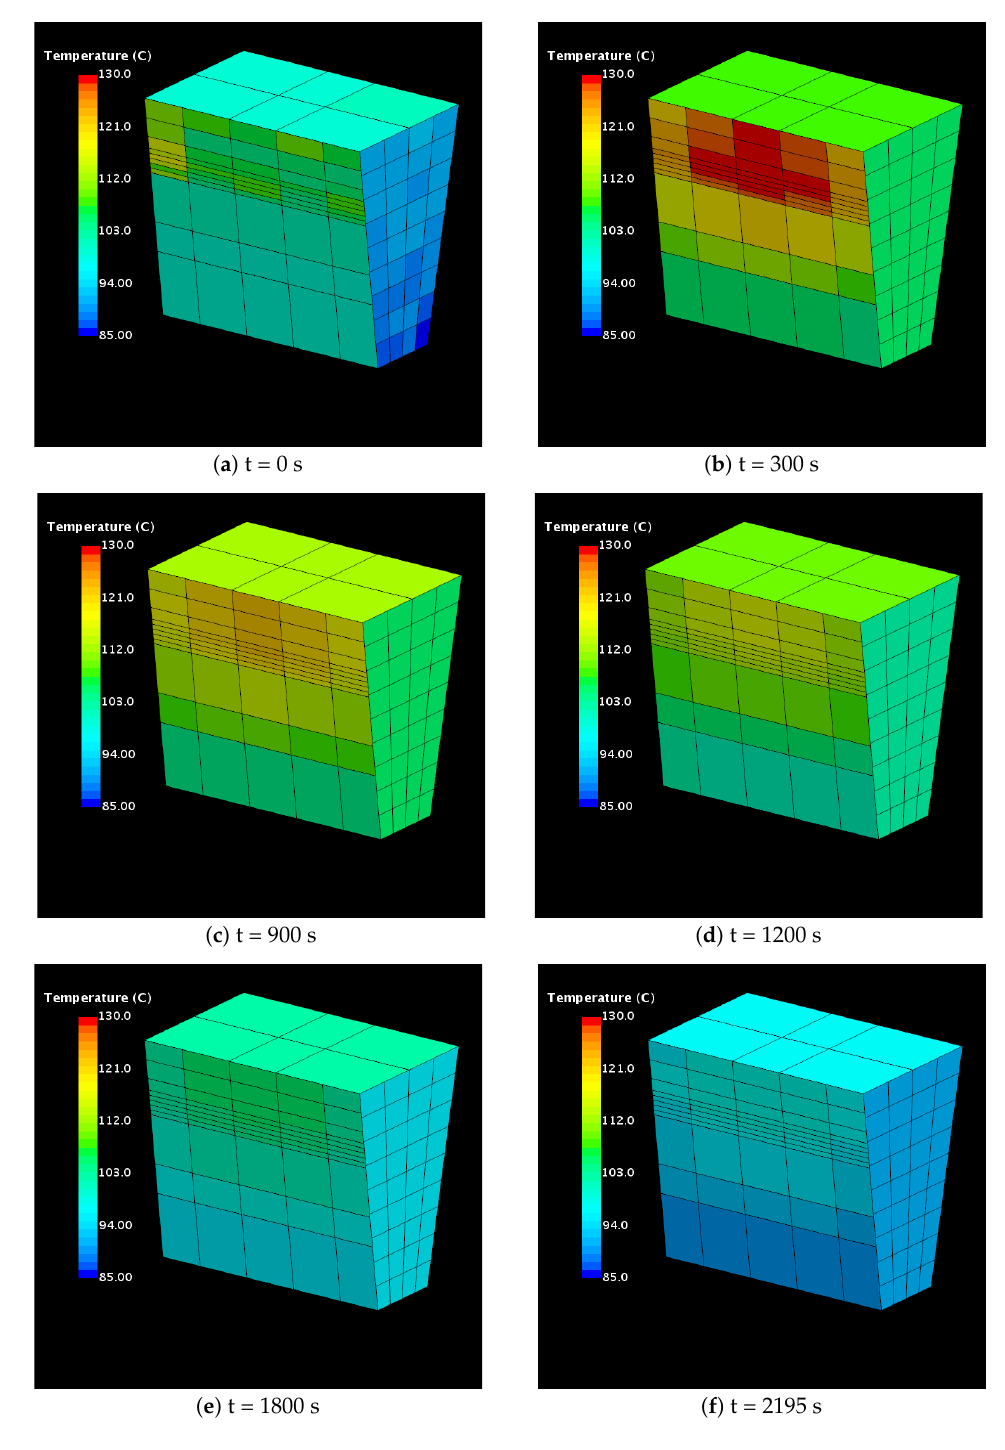
Figure 9. Simulation results for the temperature of the engine